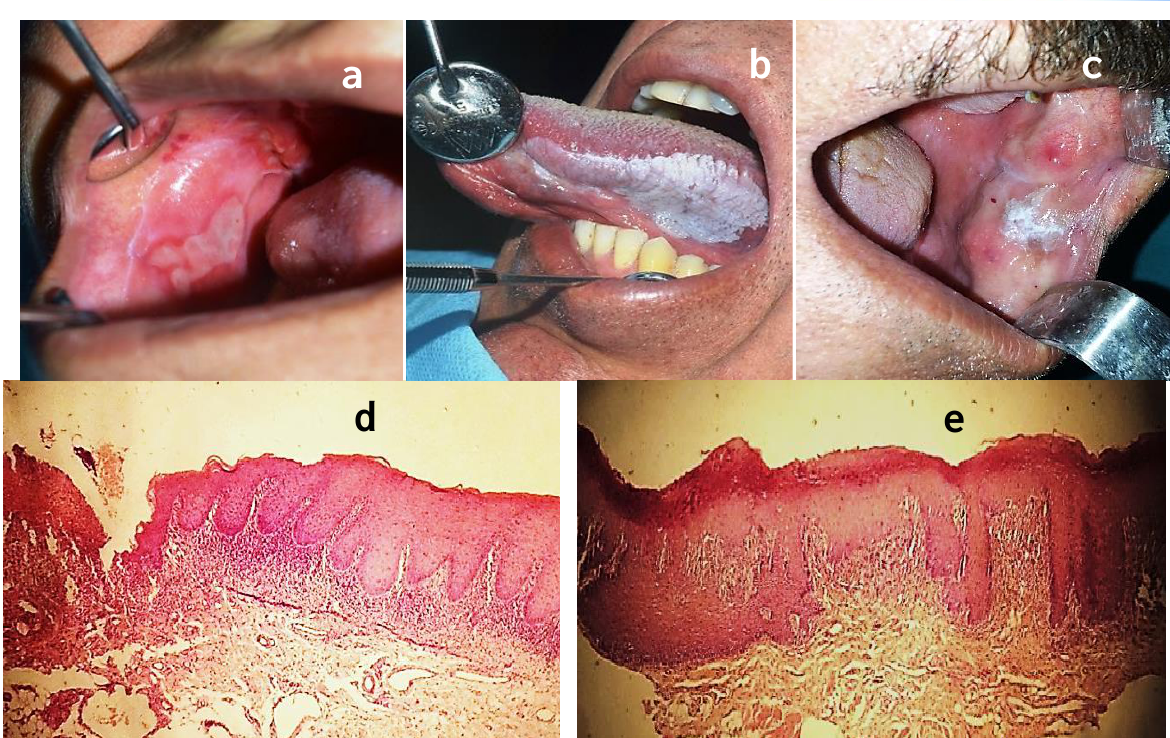
Figure 1: Clinical presentations of: a) erosive lichen planus. b &c) leukoplakia with surface keratosis. Histological appearance of d) lichen planus without dysplasia, e) lichen planus with mild dysplasia. (X100):